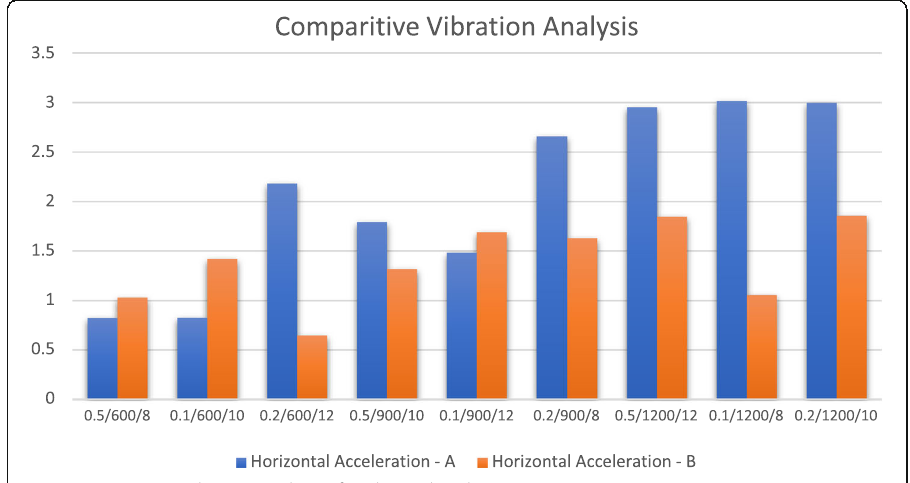
Fig. 9 Comparative vibration analysis of tool A and tool